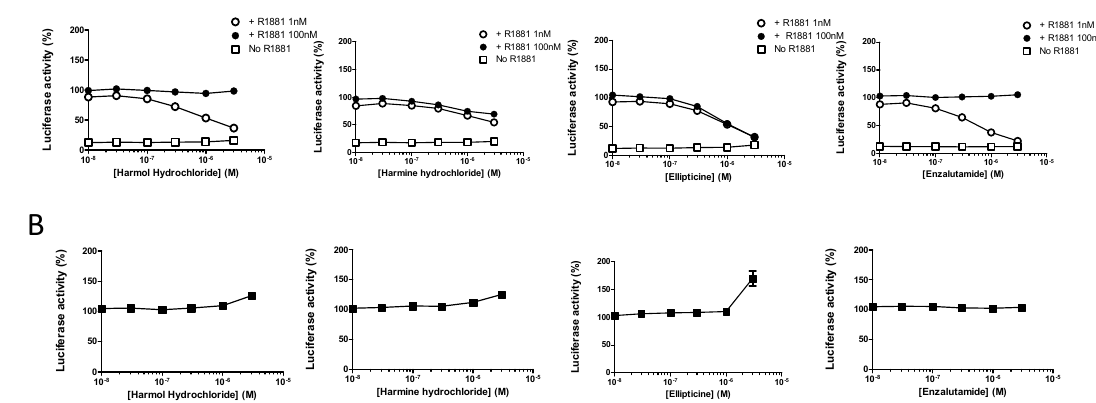
Figure 3. Harmol is a competitive antagonist of the full-length AR. Dose response curves performed with harmol, harmine, ellipticine and the AR antagonist enzalutamide antagonist activity in U2OS-hAR-ARE-Luc cells ( A ) and U2OS-ARE-Luc control cells ( B ). Cells were incubated for 16 h with 0, 0.03, 0.1, 0.3, 1, and 3 µM of tested compounds in the absence ( □ ) or in the presence of R1881 1 nM ( ○ ) and100 nM ( ) R1881.